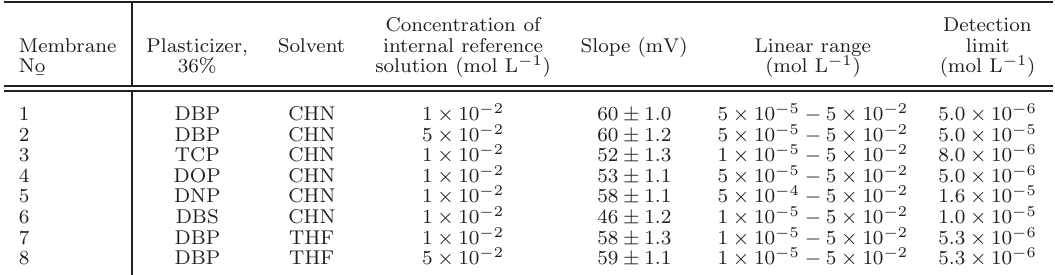
Concentration of Detection Membrane